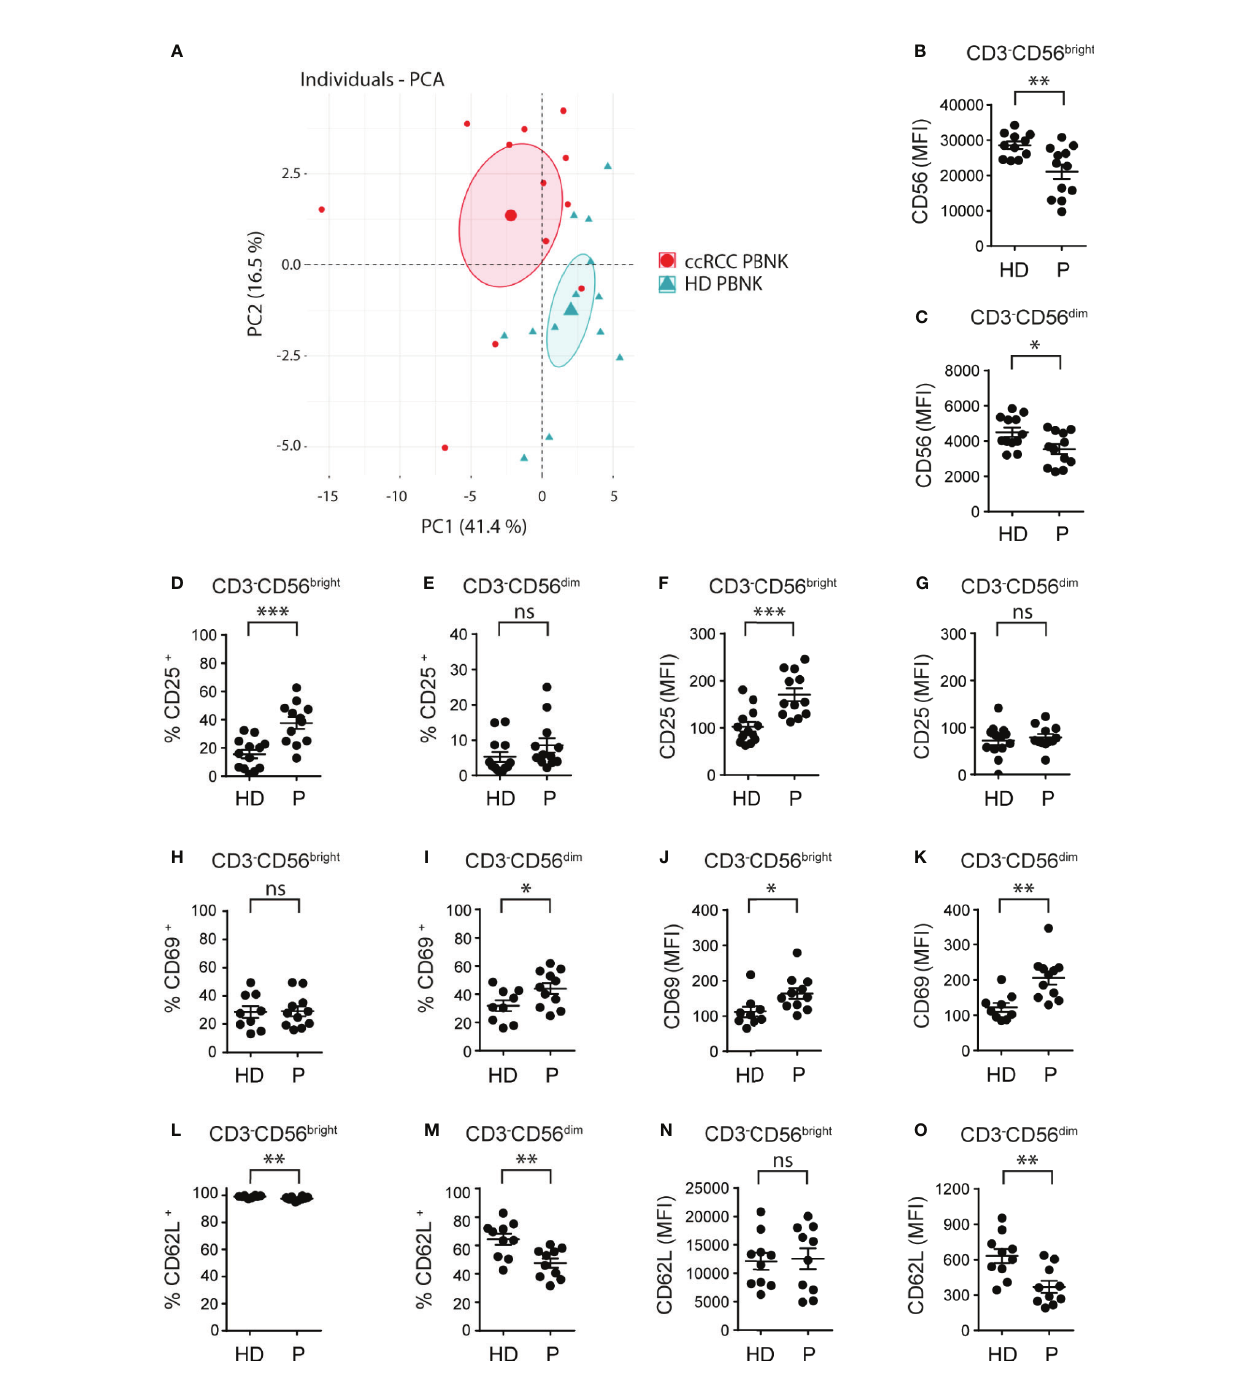
FIGURE 1 | Cell surface markers differentiate ccRCC patients from HD and indicate that PBNK from ccRCC patients exhibit an activated phenotype. MFI of the molecules analyzed on CD3 - CD56 bright and CD3 - CD56 dim cells of HD and ccRCC PBNK were used to perform a PCA (A) . The graph of individuals with the con fi dence ellipse is shown. Also, PBNK cells from healthy donors (HD) and ccRCC patients (P) were analyzed by FC to compare the intensity of expression of CD56 on CD3 - CD56 bright (B) and on CD3 - CD56 dim NK cells (C) , the frequencies of CD25 + cells in CD3 - CD56 bright (D) and in CD3 - CD56 dim NK cells (E) , the intensity of expression of CD25 on CD3 - CD56 bright (F) and on CD3 - CD56 dim NK cells (G) , the frequencies of CD69 + cells in CD3 - CD56 bright (H) and in CD3 - CD56 dim NK cells (I) , the intensity of expression of CD69 on CD3 - CD56 bright (J) and on CD3 - CD56 dim NK cells (K) , the frequencies of CD62L + cells in CD3 - CD56 bright (L) and in CD3 - CD56 dim NK cells (M) , and the intensity of expression of CD62L on CD3 - CD56 bright (N) and on CD3 - CD56 dim NK cells (O) . For HD: n =11 (B) , n =12 (C) ; n =13 (D – G) ; n =9 (H – K) and n =10 (L – O) . For P: n =12 (B – G) , n =11 (H – K) , and n =10 (L – O) . A two-sided unpaired t-test with Welch ’ s correction was used in (B – D , F – I, K – O) . A two-sided unpaired t-test with Mann-Whitney´s correction was used in (E, J) . ns, not signi fi cant; * p < 0.05; ** p < 0.01; *** p <